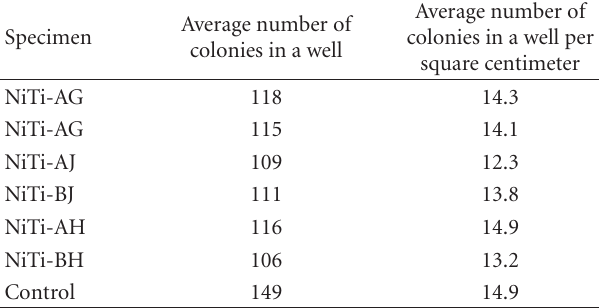
Table 3: E ffi ciency of the formation of colonies of MSCs cultivated with the NiTi specimens di ff ering in chemical composition and surface roughness. Summarized data for three specimens of each